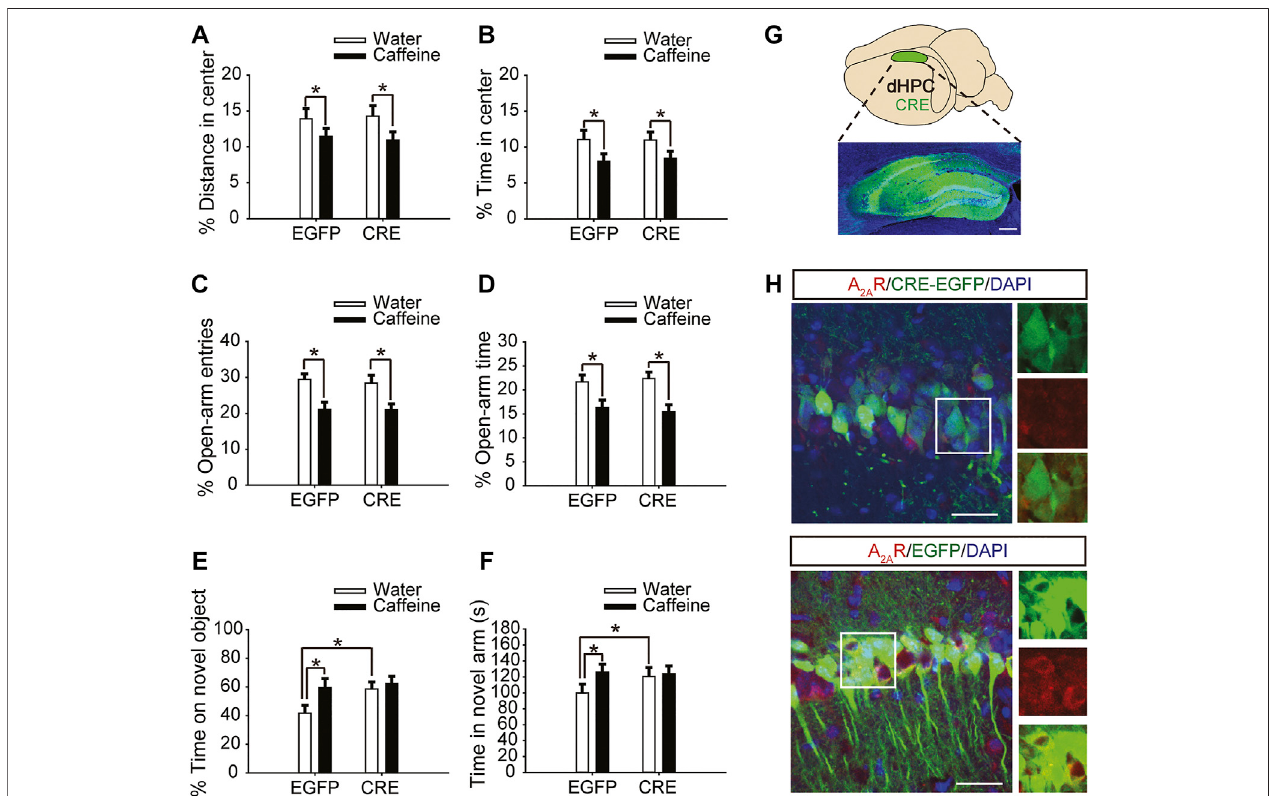
FIGURE 2 | Selective expression of pAAV-CRE in the dHPC triggers memory enhancement. (A,B) Behavior of the four groups of mice in the open- fi eld test. Caffeinedecreasedthetimeinthecenter (B) anddistanceincenter (A) inCREandEGFPmice. (C,D) BehaviorofthefourgroupsofmiceintheElevatedPlusMaze(EPM) test. Caffeine decreased the percentage of open-arm entries (C) and the percentage of time spent in the open arms (D) in CRE and EGFP mice. (E) Behavior of the four groups of mice in the Novel Object Recognition (NOR) test. The time spent exploring a novel object was increased by caffeine only in EGFP mice during the testing trial. (F) BehaviorofthefourgroupsofmiceintheY-mazetest.ThetimespentinthenovelarmwasincreasedbycaffeineonlyinEGFPmiceduringtheretrievalphase. (G) SelectedexpressionofAAV-CREinthedHPC(scalebar=500 μ m). (H) ImagesofhippocampalbrainsectionsobtainedfrommiceinjectedwithAAV-CREorAAV-EGFP (scale bar = 30 μ m). The level of A 2A R (red) was lower in CRE-positive cells (upper panel) than in cells transfected with pAAV-EGFP (lower panel). Data are presented as the mean ± SEM; n = 7 mice per group; * p < .05, two-way ANOVA, Bonferroni post hoc t-test.